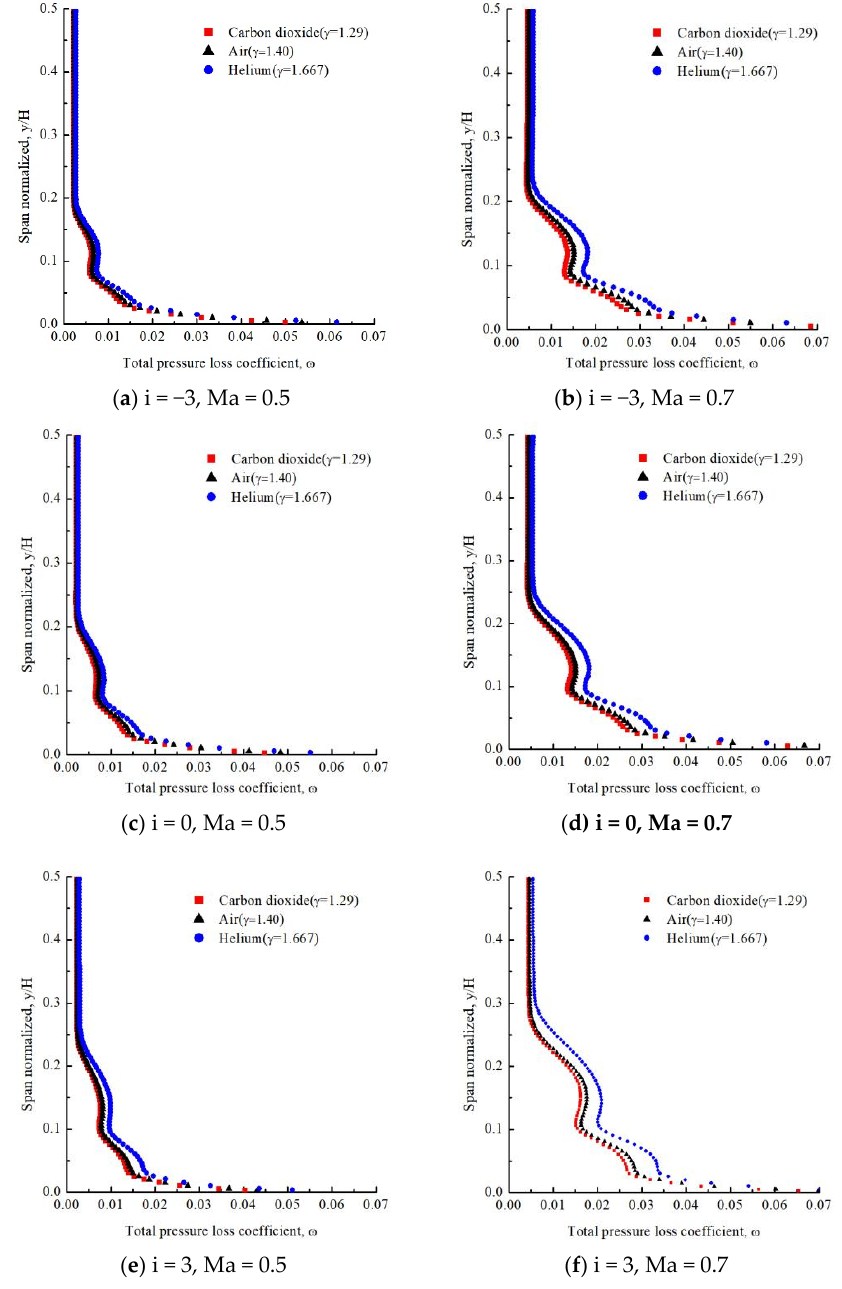
Figure 8. Distribution of coefficient of total pressure loss over blade height.